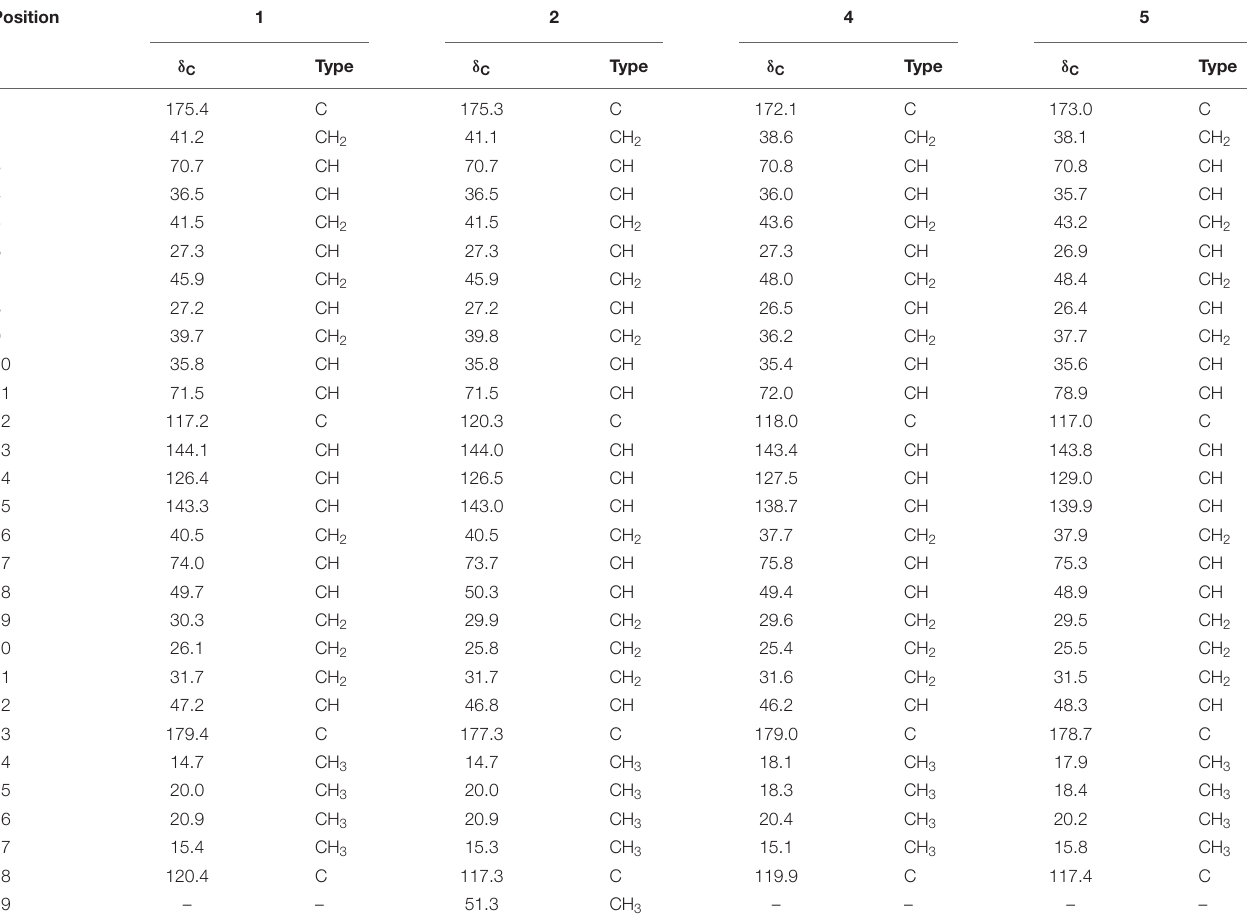
TABLE 2 | 13 C NMR (150 MHz) data for 1 , 2 , 4 , and 5 in pyridine- d 5 .